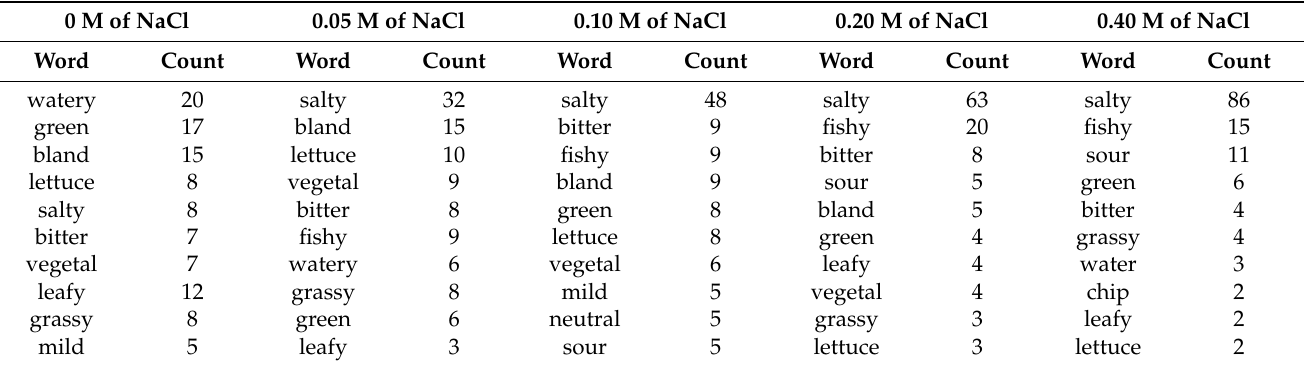
Figure 3. Radar plot of six flavor aspects. Polar axis represents intensity of six categories of flavor including saltiness, bitterness, sweetness, sourness, fishiness, and green flavor on a 7-point scale (1 = not at all; 7 = very strong). Data for each attribute are means of the 115 ratings. Table 2. Number of most frequently appearing words in the description of the flavor of ice plant samples in response to sodium chloride (NaCl) treatment in hydroponic nutrient solution.